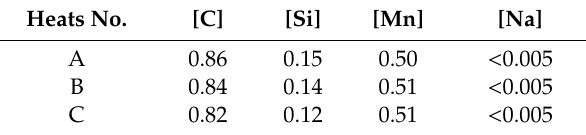
Table 3. Composition of steel after reaction